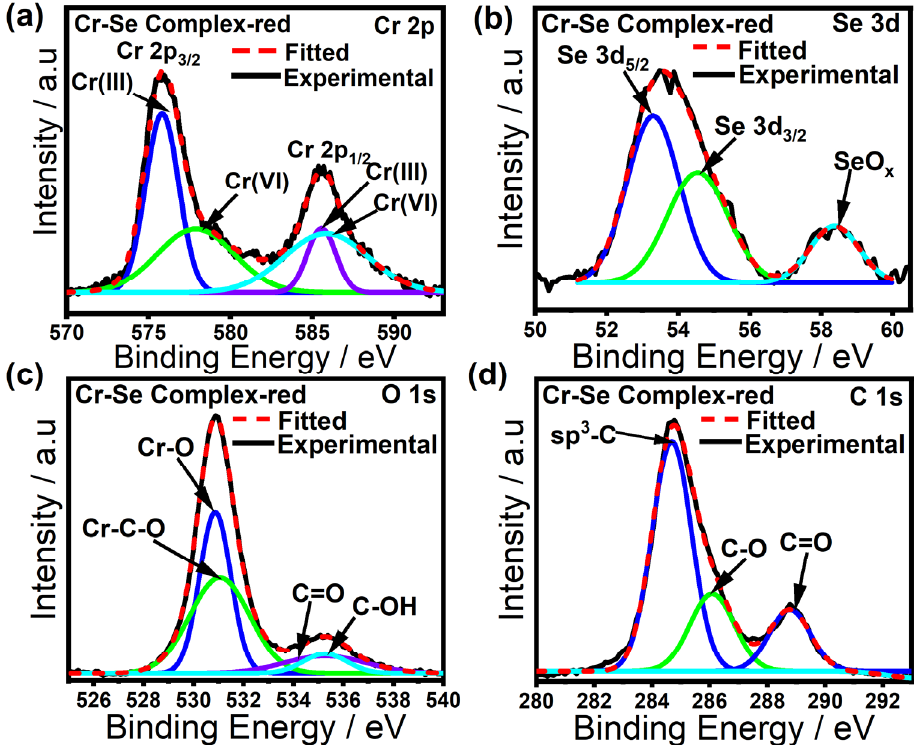
Figure 2. The high-resolution XPS spectra of Cr-Se red complex showing ( a ) Cr 2p peak; ( b ) Se 3d peak; ( c ) C s1 peak; ( d ) surface O 1s peak. peak; ( c ) C s1 peak; ( d ) surface O 1s